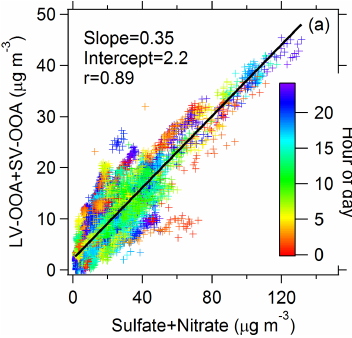
Fig. 8. The scatter plot of total OOA (LV-OOA + SV-OOA) versus secondary inorganic species (sulfate + ammonium). The data points are color-coded according to diurnal time of measurement.